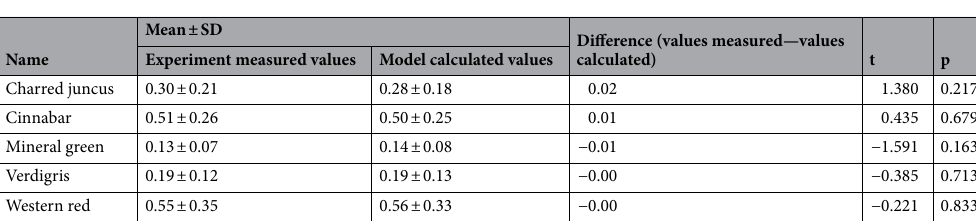
Table 3. Paired t-test analysis results.